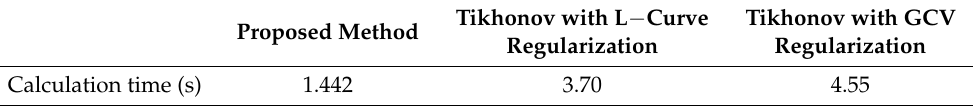
Table 3. Calculation time in Example